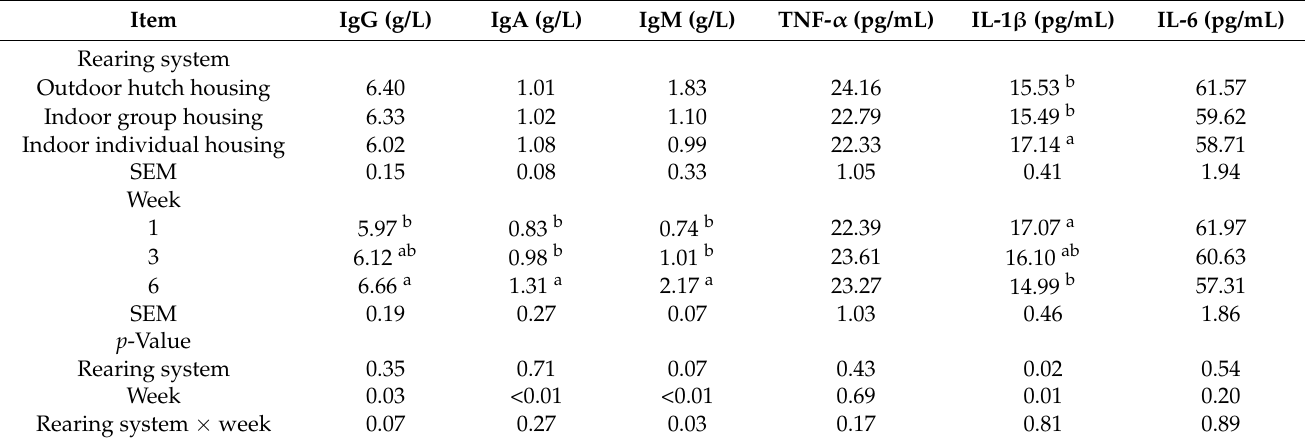
Table 4. Immunity parameter values for the calves in the